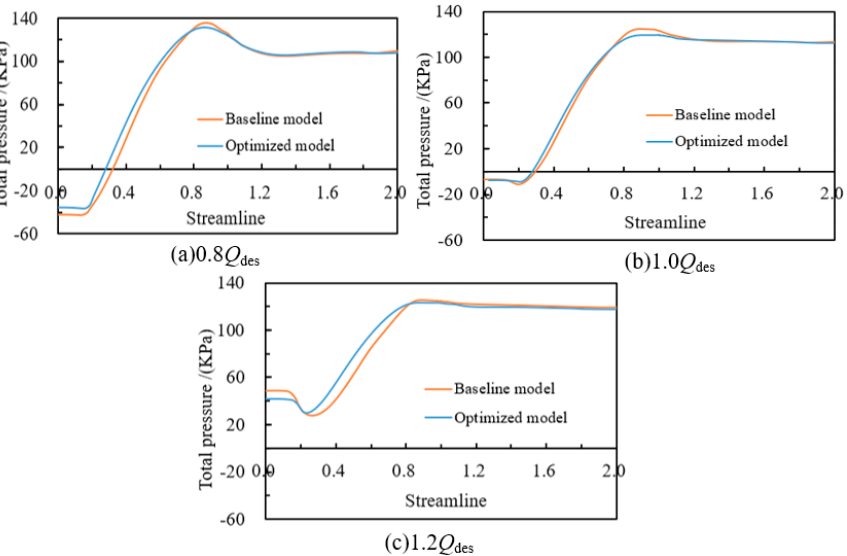
Figure 14. Total pressure distribution along the streamline.